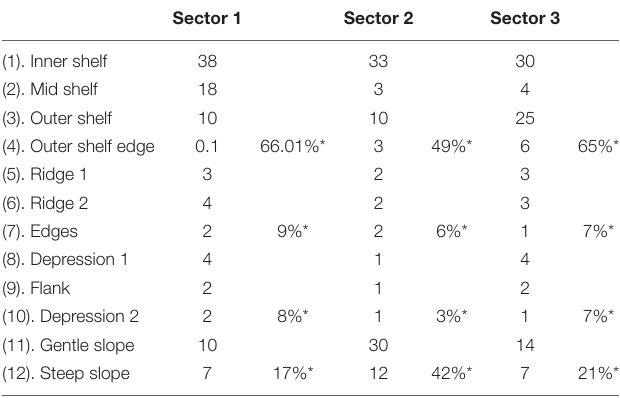
TABLE 3 | Percentage of seabed classes per